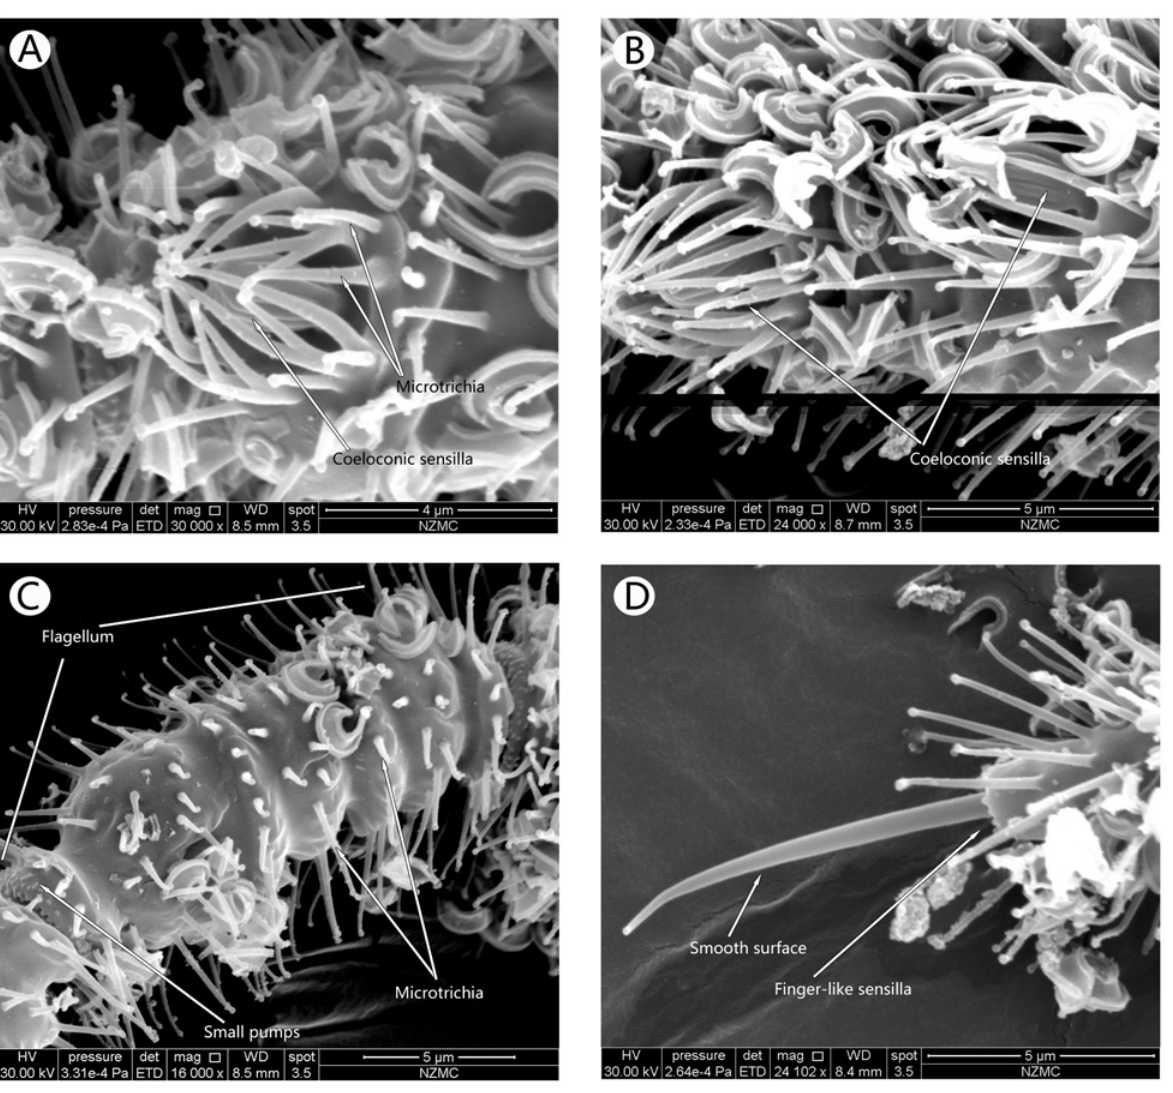
Fig 6. Coeloconic sensillaIandII, Microtrichia sensilla and Finger-like sensilla of MEAM1. Ventral surface of the third flagellum showing the Coeloconic sensilla I in MEAM1 female (A). Ventral surface of the first flagellum with the Coeloconic sensilla II in MEAM1 male (B). Microtrichia sensilla in the second flagellum of MEAM1 male (C) and Finger-like sensilla in the fifth flagellum of MEAM1 male